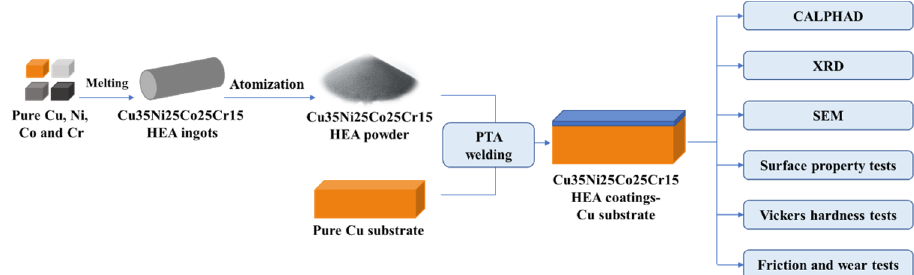
Figure 1. Flowchart of material preparation and research